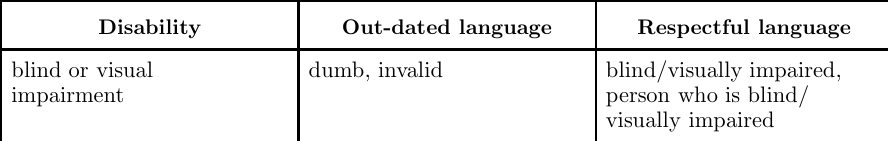
Different descriptions of